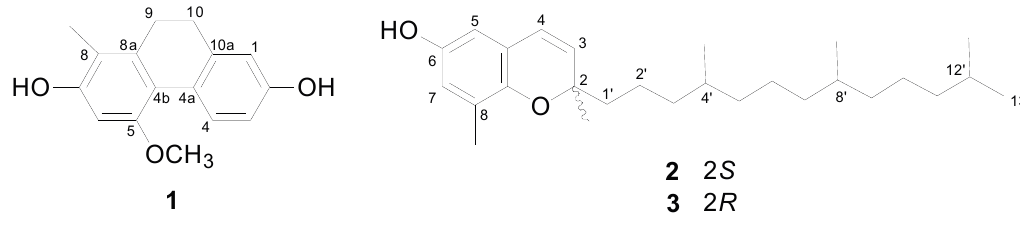
Figure 1. Chemical structures of the isolates 1 – 3 from the root of S. tuberosa